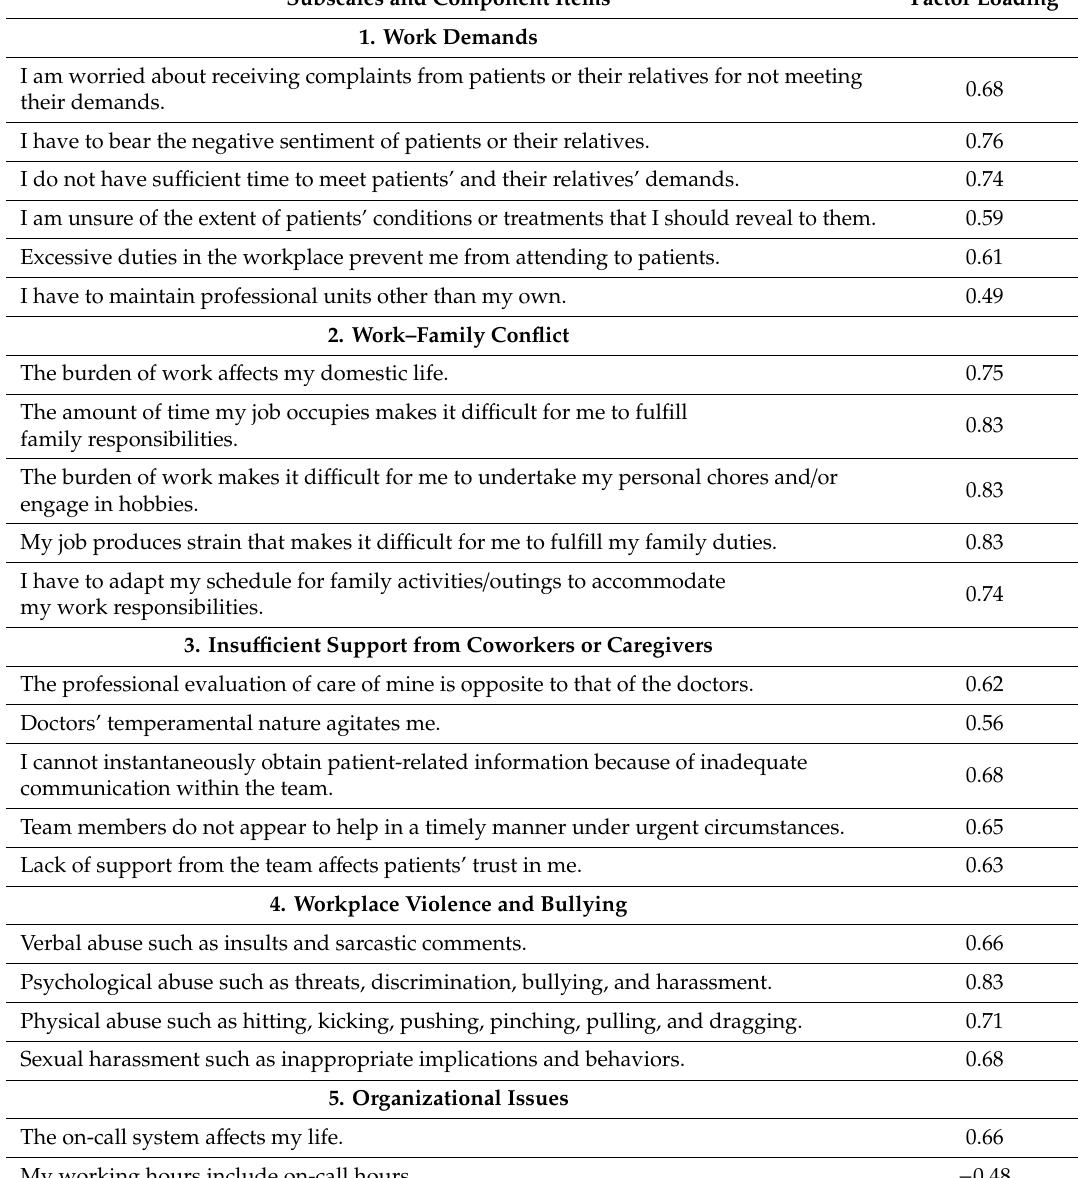
Table 2. Factor loadings for items loaded on 10 factors of the 43-item Nurses’ Occupational Stressor Scale (NOSS) through varimax